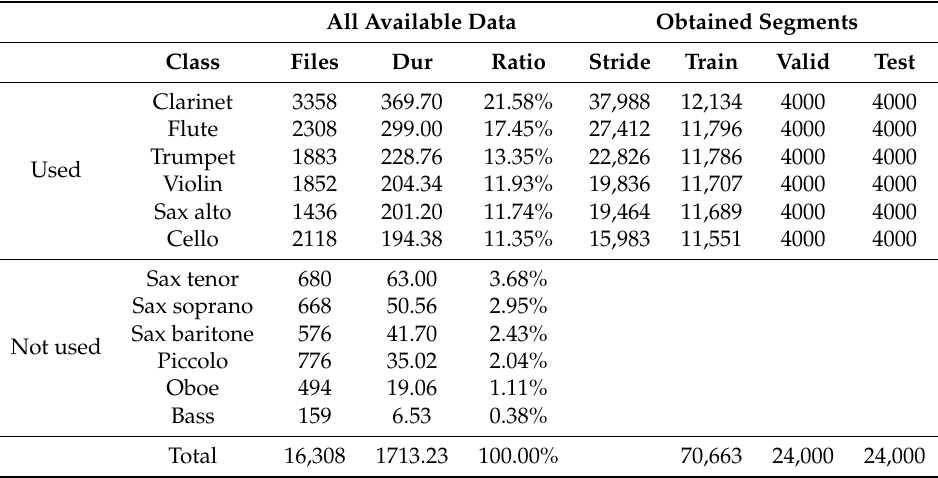
Table 3. Overview of available and used data. All Available Data Obtained